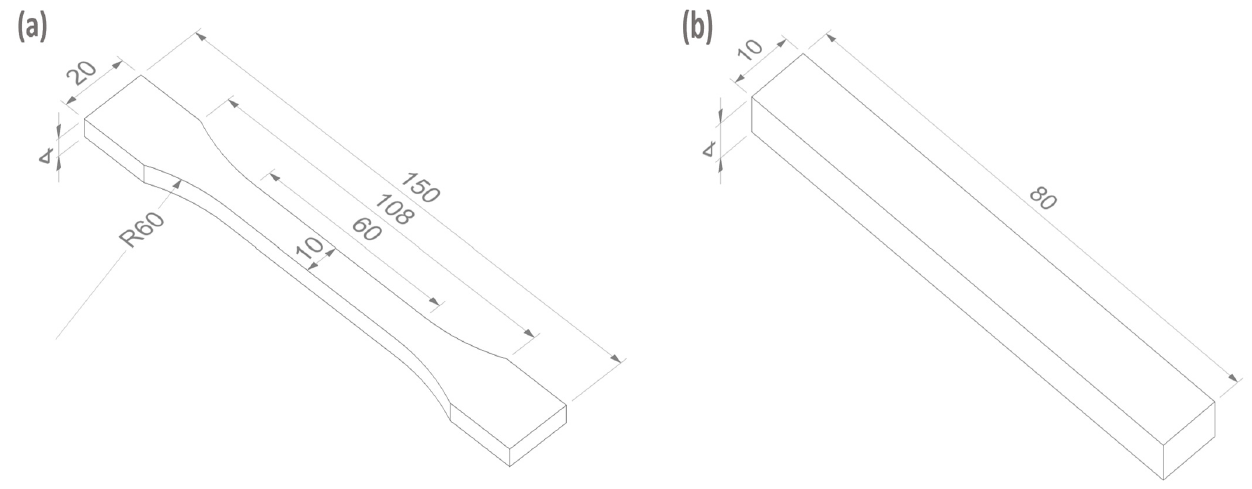
Figure 1. Samples for testing: ( a ) tensile sample; ( b ) flexural sample. Dimensions are in mm. Table 2. Combination of processing parameters (N = nozzle temperature; B = print bed temperature; Table 1. Characteristics of graphene-enhanced PLA material. P = print